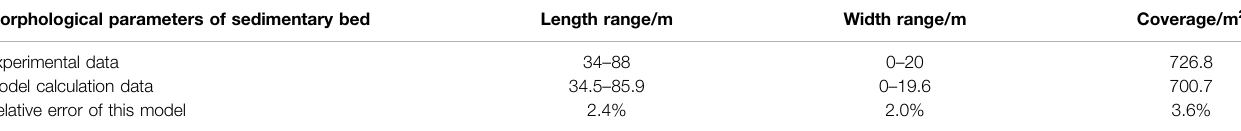
TABLE 2 | Comparison of experimental data and model calculation data of sedimentary bed morphology